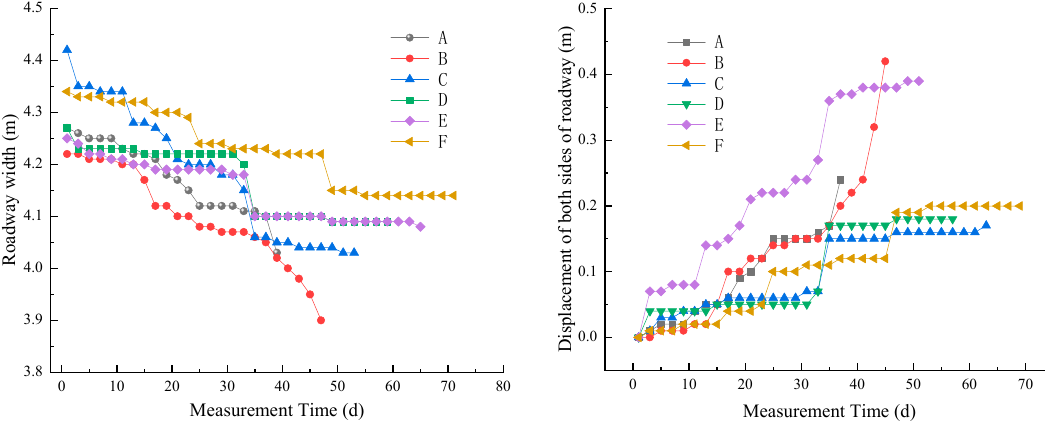
Figure 12. Variation curve of distance between two sides of ZF3806 mining roadway.